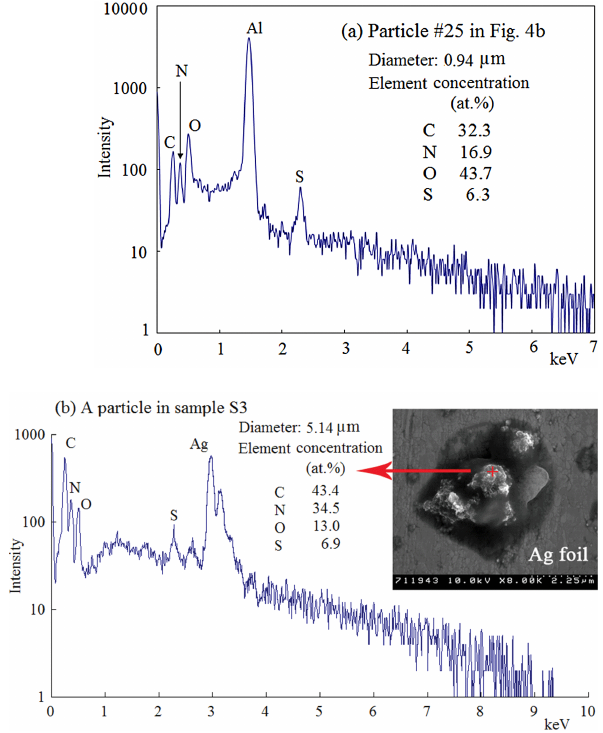
Fig. 11. Typical (C, N, O, S)-rich particles. (a) A typical particle collected on Al foil and (b) a typical particle collected on Ag foil (N concentration is relatively